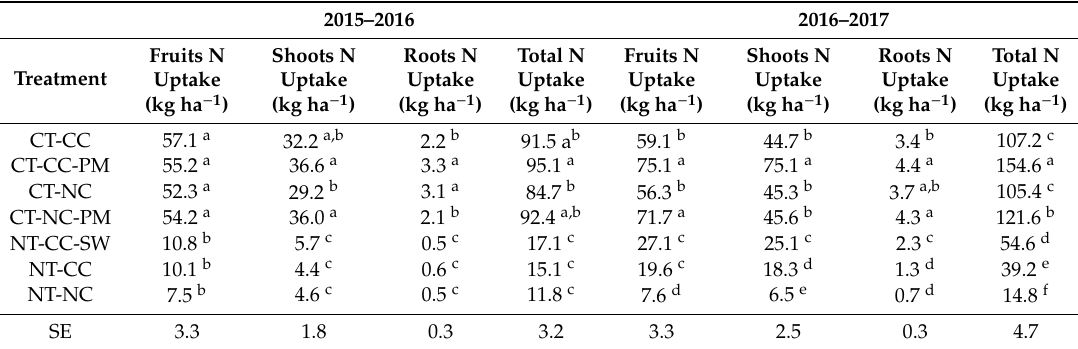
Table 3. N uptake by tomato plants as a ff ected by tillage and cover crop management.